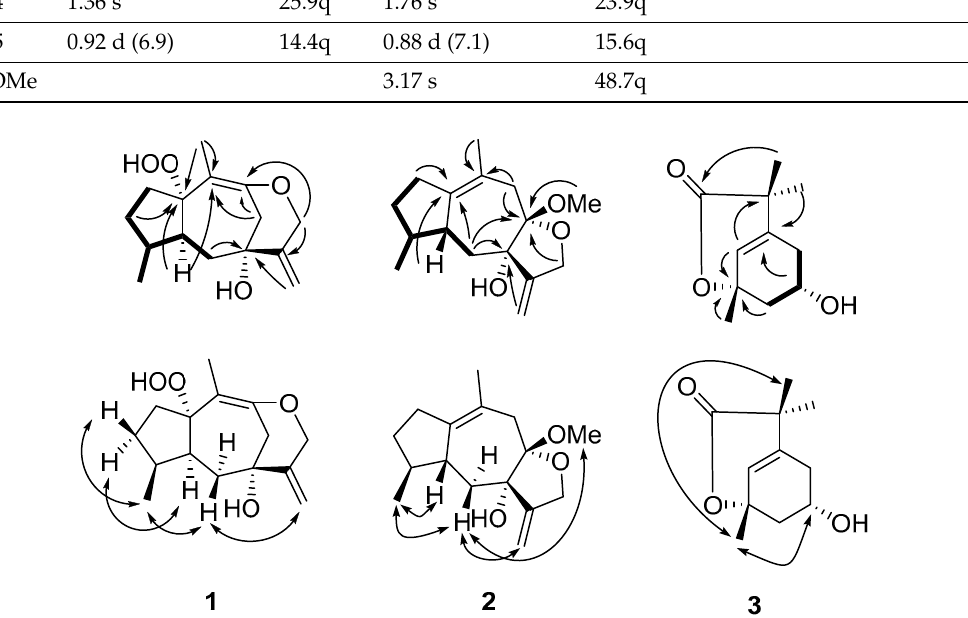
Figure 2. Key 1 H- 1 H COSY ( – ), HMBC (H → C), and ROESY ( ↔ ) correlations of 1 – 3. Table 1. 1 H (400 MHz) and 13 C NMR (100 MHz) Data of Compounds 1 – 3 (in CDCl 3 ).